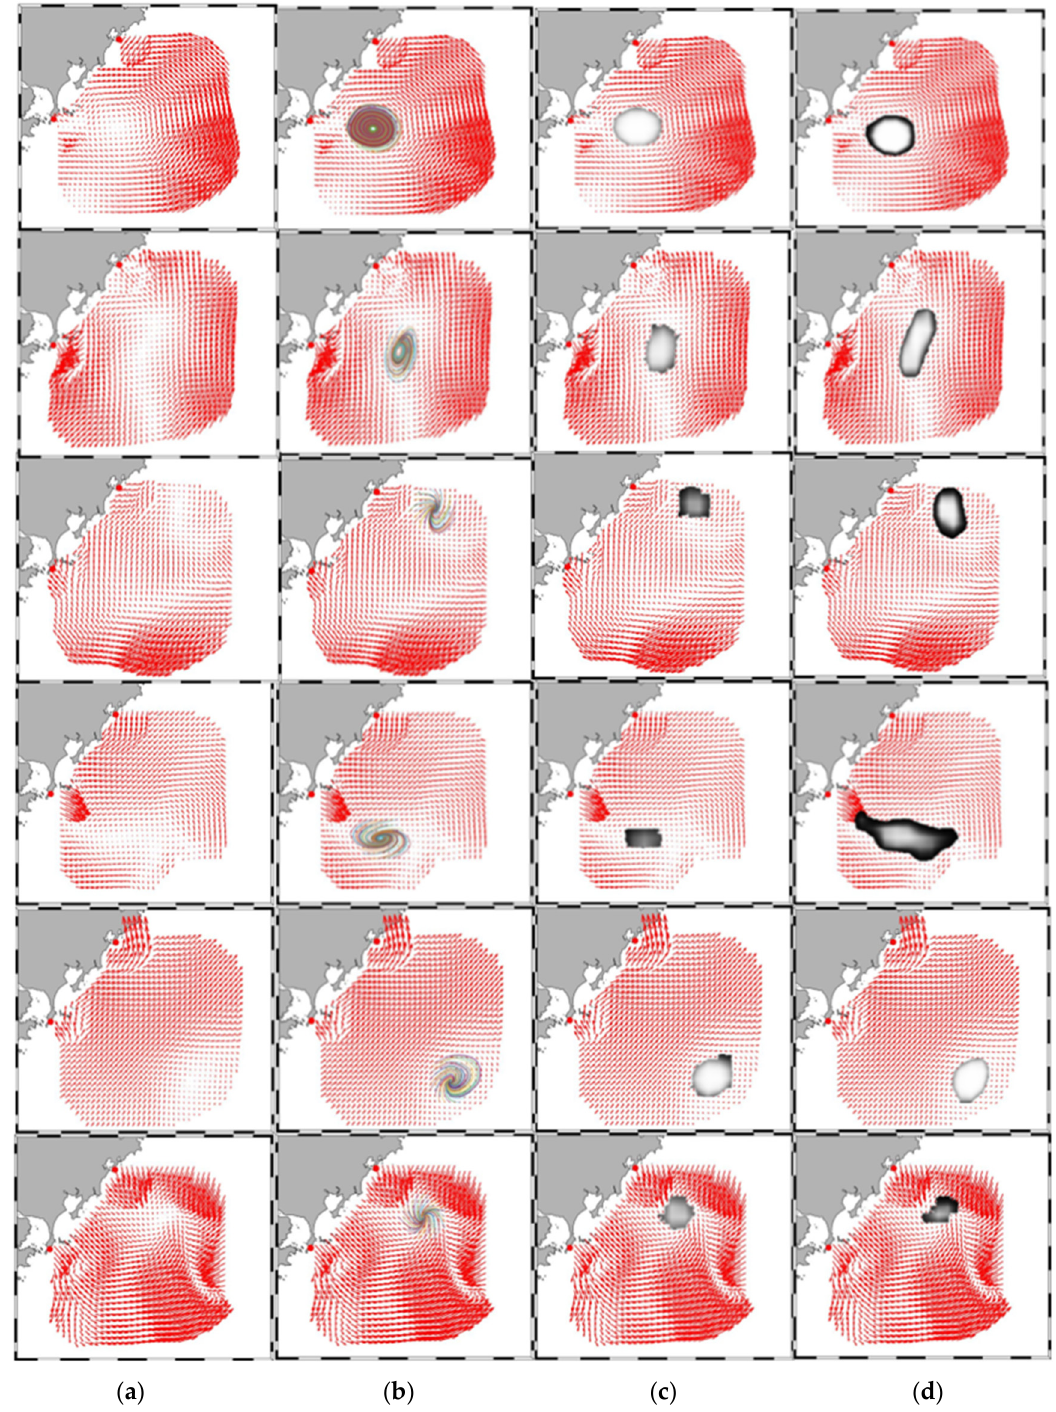
Figure 4. Comparison of eddy detection results between ground truth, FCN-based eddy network and DEDNet. ( a ) Original flow chart; ( b ) Ground truth eddies; ( c ) Eddy detected by DEDNet; ( d ) Eddy detected by a FCN-based network.